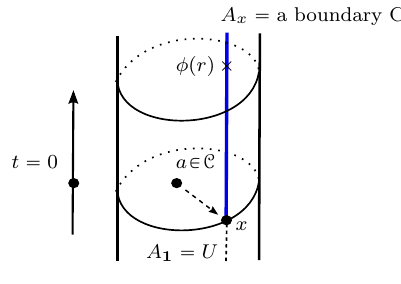
Figure 4 . This picture depicts a 2d topological order p C ; c q on a 2-disk, together with a 1d gapless edge, propagating in time. At t (cid:16) 0, we move a bulk particle a to the edge. The blue world line is supported on x